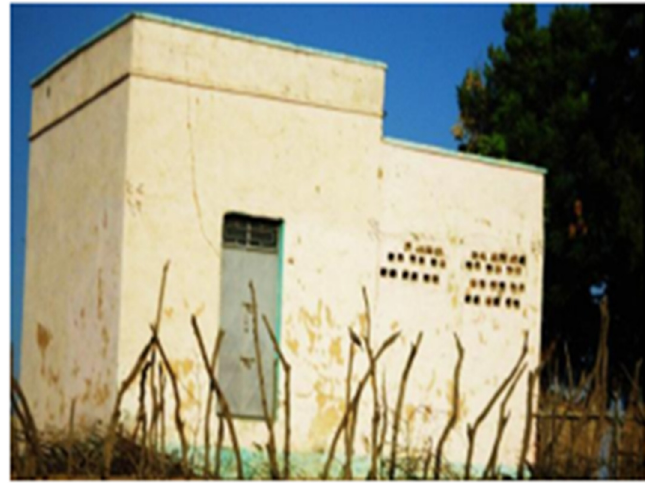
Figure 14. White painted external wall .